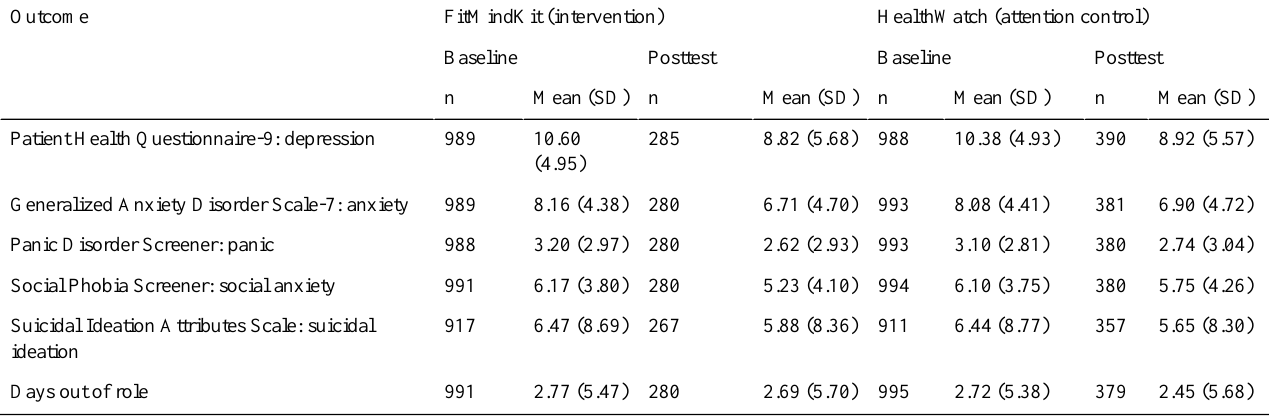
Table 2. Observed means (SD) for outcome variables at baseline and